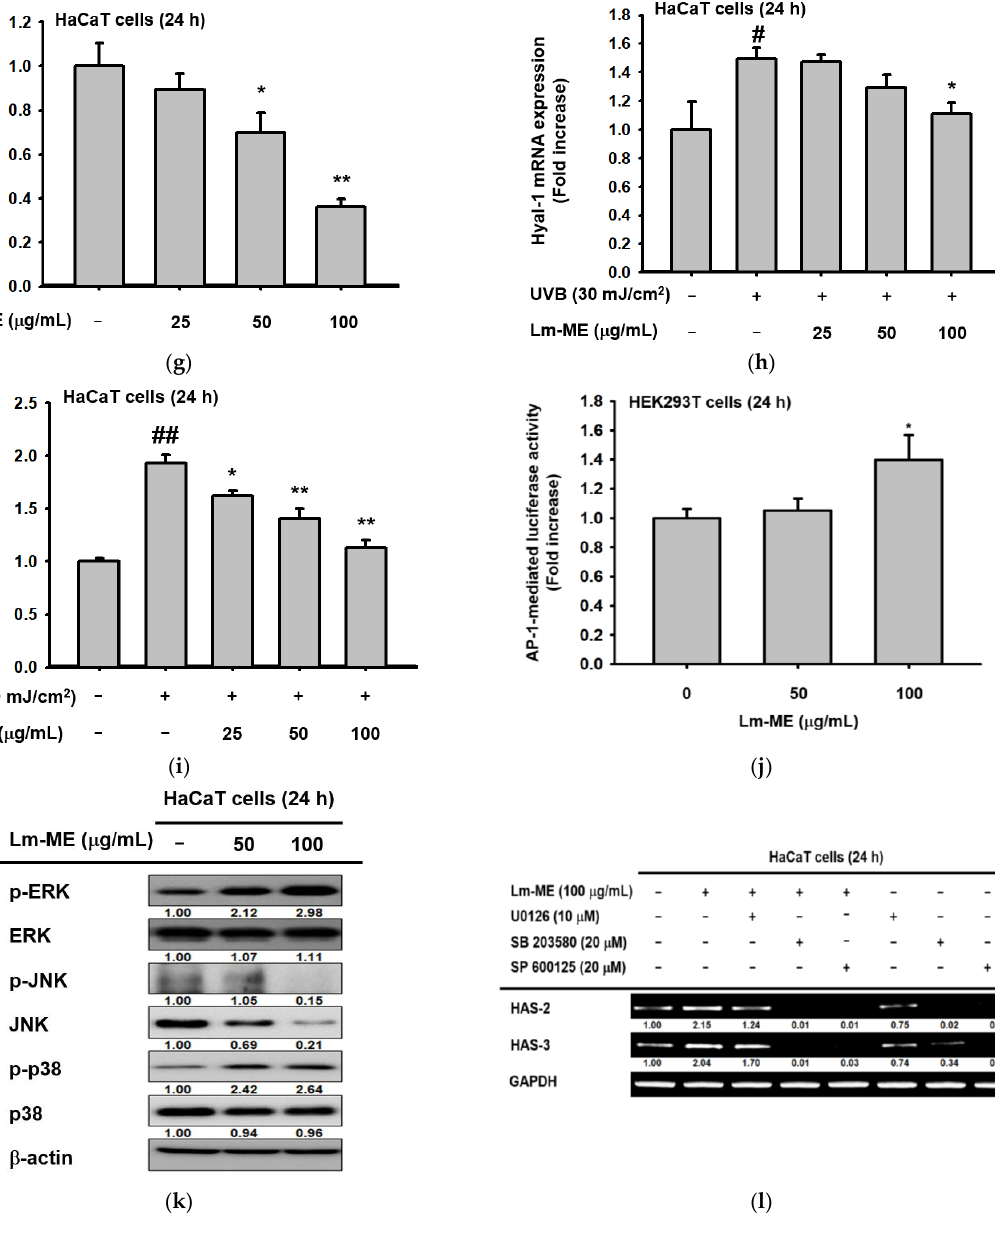
Figure 3. The hydration effects of Lm-ME in HaCaT cells. ( a , b ) After treatment with Lm-ME for 24 h, the hydration-related genes (HAS-2, -3, and TGM-1) were analyzed in HaCaT cells by semi-quantitative and real-time PCR. GAPDH was used as an internal control. ( c , d ) Hyaluronic acid levels were determined from culture supernatants of normal Lm-ME-treated or UVB-irradiated HaCaT cells using the carbazole assay. ( e – i ) The mRNA expressions of Hyal-1, -2, and -4 were determined from normal Lm-ME-treated or UVB-irradiated HaCaT cells using real-time PCR. ( j ) The AP-1 luciferase construct and β -gal (as control) were transfected for 24 h. The HEK293T cells were then treated with Lm-ME at different concentrations (0–100 µ g/mL). Luciferase activity was measured using a luminometer. ( k ) The HaCaT cells were treated with Lm-ME (0–100 µ g/mL) for 24 h. The levels of phosphorylated, as well as the total ERK, JNK, and p38 gene products, were tested using immunoblotting. ( l ) The HaCaT cells were then treated with Lm-ME (0–100 µ g/mL) and MAPK inhibitors, such as U 0126, SB 203580, and SP 600125. After this treatment, the mRNA expression levels of HAS-2 and HAS-3 were analyzed using semi-quantitative PCR. The relative intensity of bottom values of a, k, and l are measured using ImageJ. #: p < 0.05 and ##: p < 0.01 compared to the normal group, and *: p < 0.05 and **: p < 0.01 compared to the control